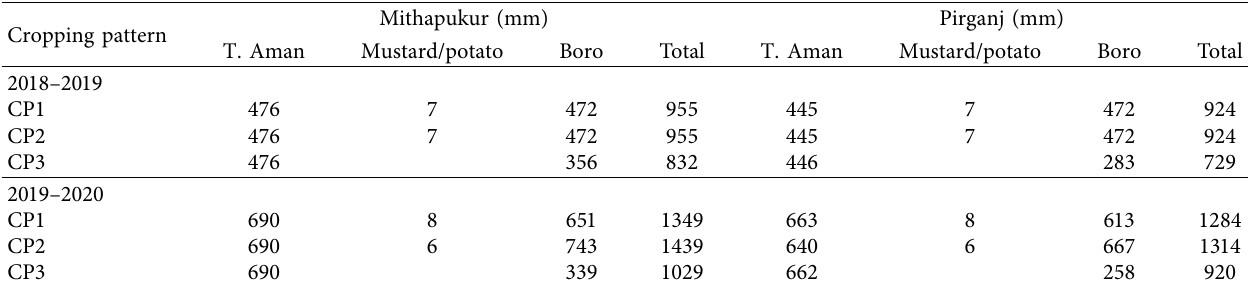
Table 1: Rainfall (mm) received by different crops in the three cropping patterns (CP1: T. Aman-Mustard-Boro, CP2: T. Aman-Potato- Boro, CP3: T. Aman-Fallow-Boro) during 2018–2019 and 2019–2020 seasons Cropping